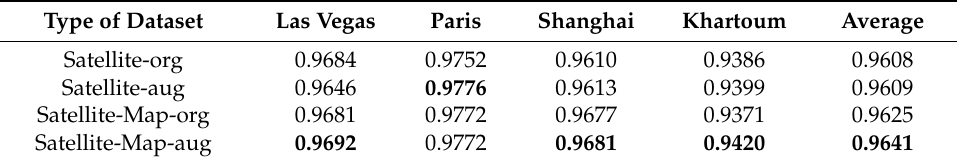
Table 3. Validation accuracies of semantic segmentation networks in four